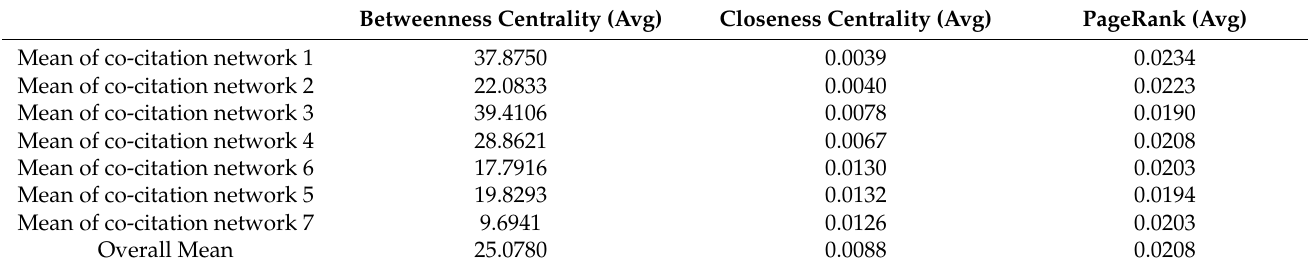
Table 17. Average betweenness, closeness centrality and PageRank per co-citation network compared to the average mean of the